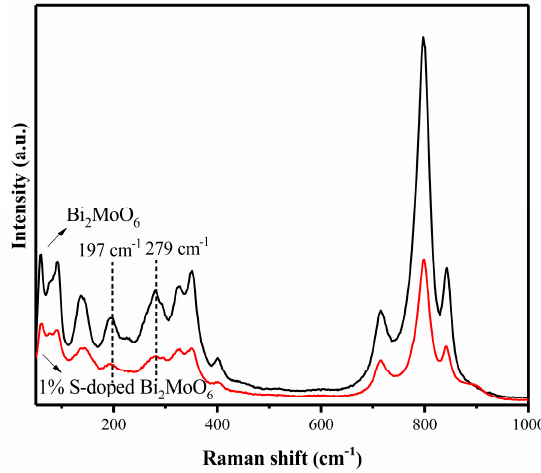
Figure 4. Raman spectra of Bi 2 MoO 6 and 1% S-doped Bi 2 MoO 6.